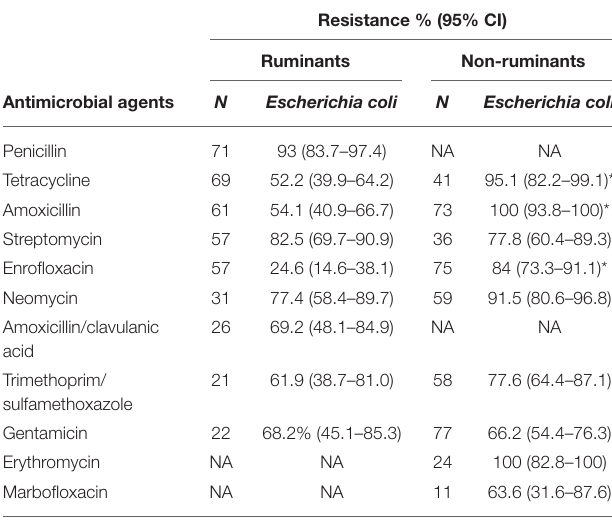
TABLE 3 | Antimicrobial resistance profiles among E. coli isolates from diseased ruminants and non-ruminants between 2015 and